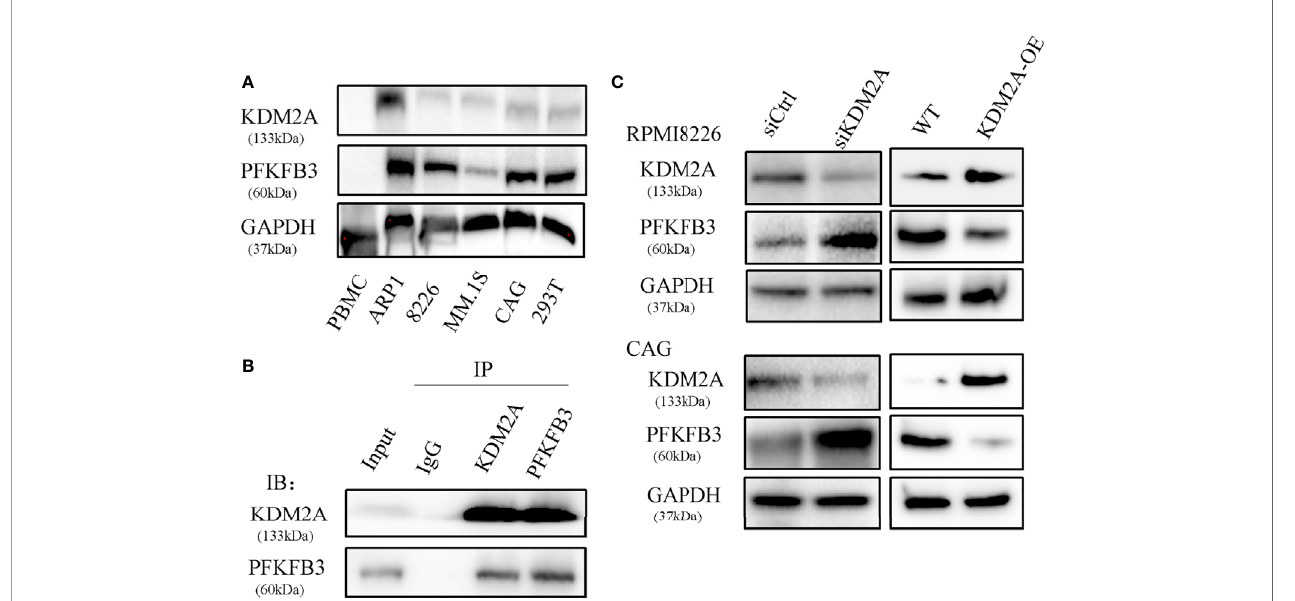
FIGURE 1 | PFKFB3 is a substrate of KDM2A. (A) Western blot analysis of expression of PFKFB3 and KDM2A in MM cell lines, PBMCs and 293T cells. PBMC: normal healthy donors ’ peripheral blood mononuclear cells as the control. (B) Co-IP assay to detect that endogenous KDM2A and PFKFB3 interacted with each other in RPMI8226 cells. (C) Western blot analysis showed that PFKFB3 protein levels increased in RPMI8226 and CAG cells transfected with siKDM2A. The gain-of-function assays validated the suppressive effect of KDM2A on PFKFB3 as well. GAPDH was used as a loading control. All the experiments were repeated three